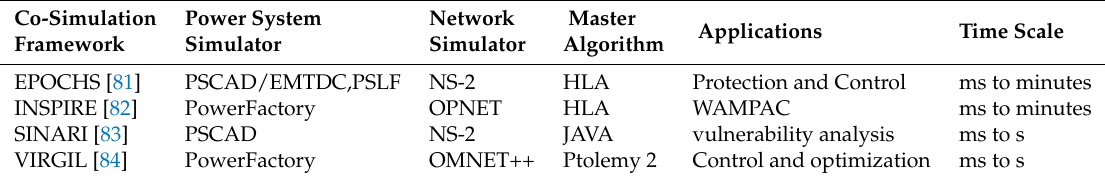
Table 3. Some co-simulation frameworks with master orchestrator in the domain of CPES. Co-Simulation Power System Network Master Applications Time Scale Framework Simulator Simulator